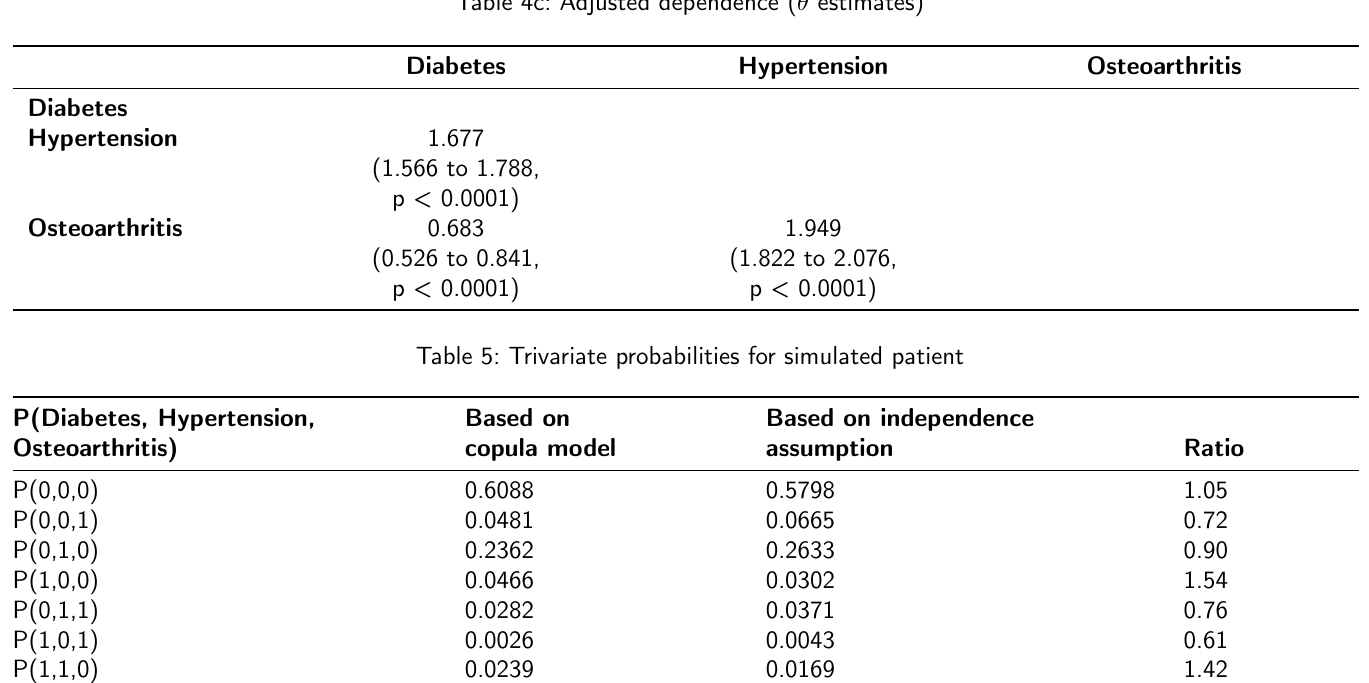
Table 4c: Adjusted dependence ( θ estimates)